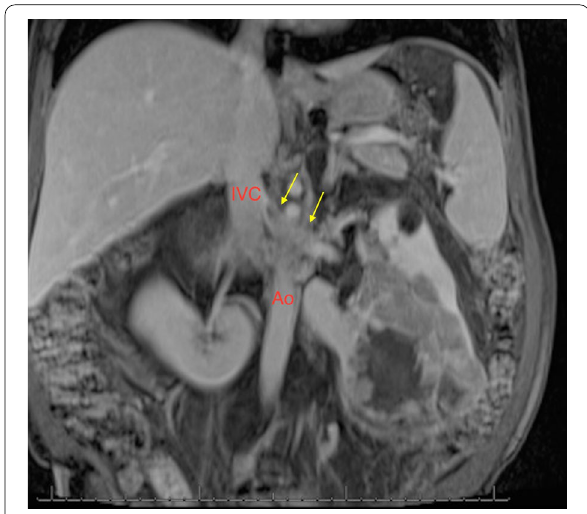
Fig. 2 Coronal MRI image showing relation of tumor and thrombus with respect to major blood vessels